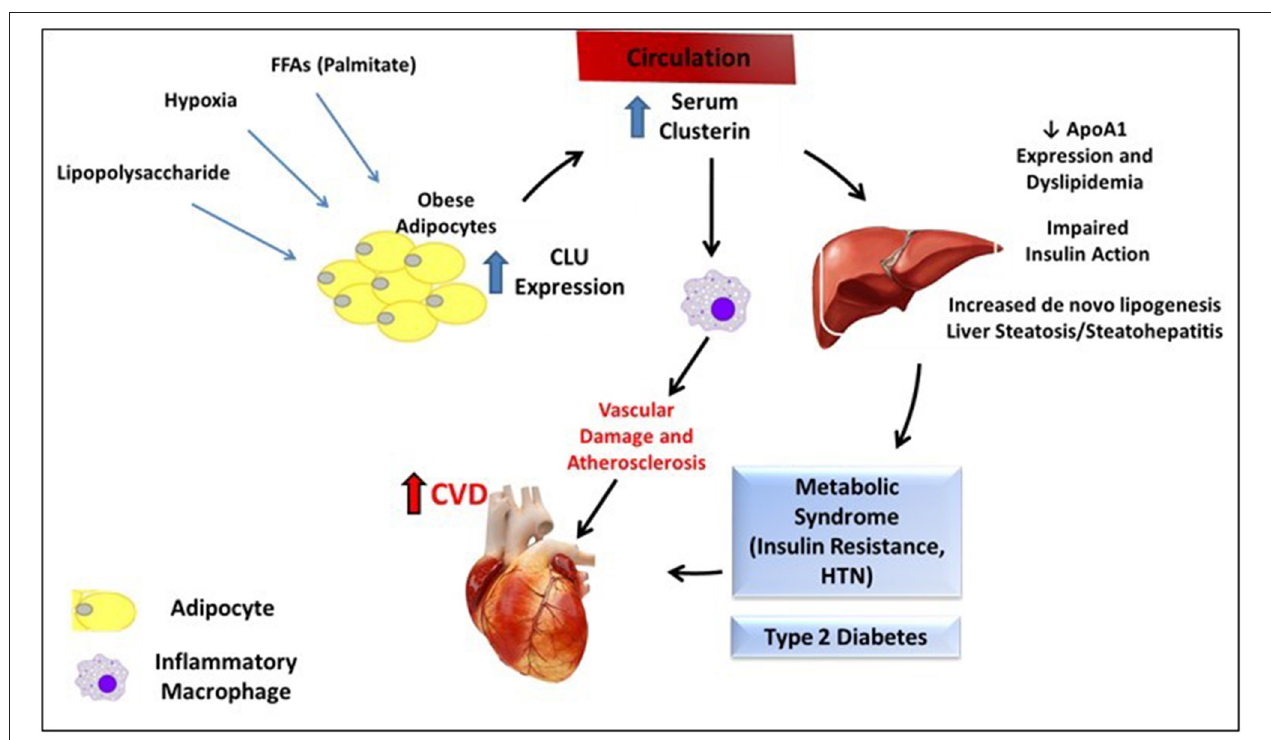
FIGURE 1 | Summary of proposed mechanism for clusterin-mediated cardiometabolic disease. Various stimuli may increase adipocyte expression of CLU from adipocytes in the setting of obesity. Circulating clusterin subsequently has multiple effects on the liver (reduction in ApoA1 expression, dyslipidemia, impaired insulin signaling, and potentially increased steatosis and inflammation) and on macrophages, which may contribute to the cardiometabolic syndrome, and increase CVD